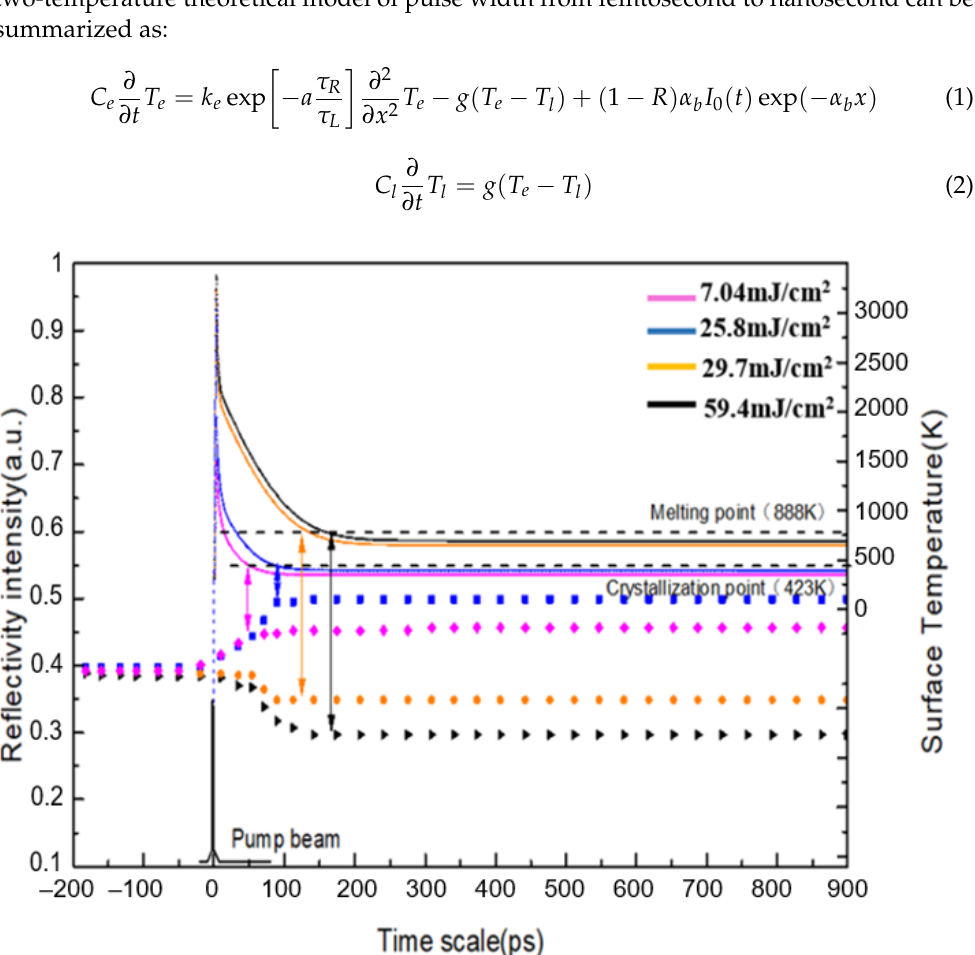
Figure 4. The pump-probing reflectivity signals of femtosecond laser induced crystallization and ablation of Ge 2 Sb 2 Te 5 with difference laser fluences in scatter-points, and the corresponding simulated surface temperature as a function of time for the applied laser fluences in solid lines. Equations (1) and (2) show the heat transfer process of electron and lattice Table 1. Parameters for Ge 2 Sb 2 Te 5 used in heat calculation [16,31,32].